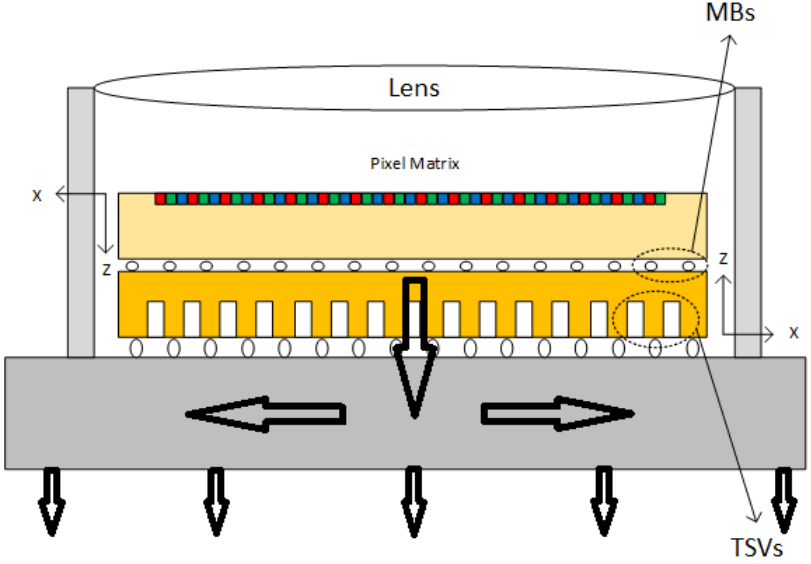
Figure 3. Example of heat dissipation/thermal conduction on 3D-stacked CIS.